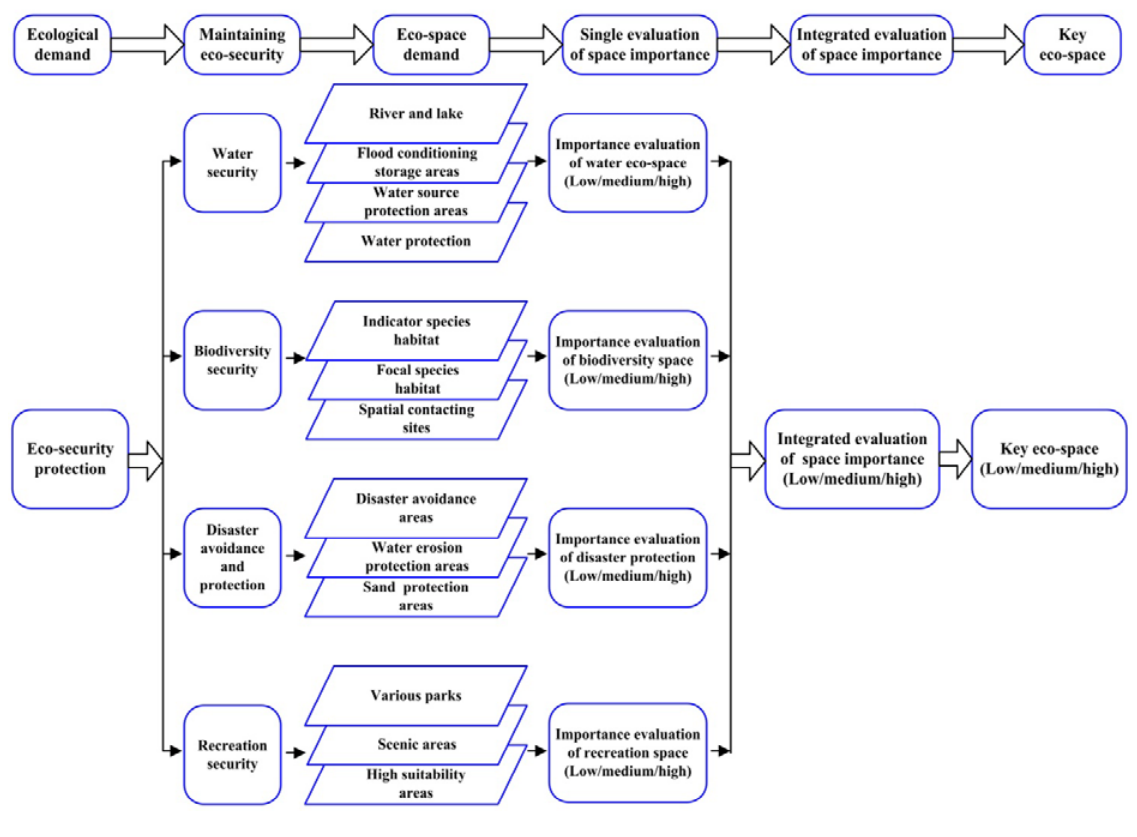
Figure 1. The framework for identifying key eco-space for ecological